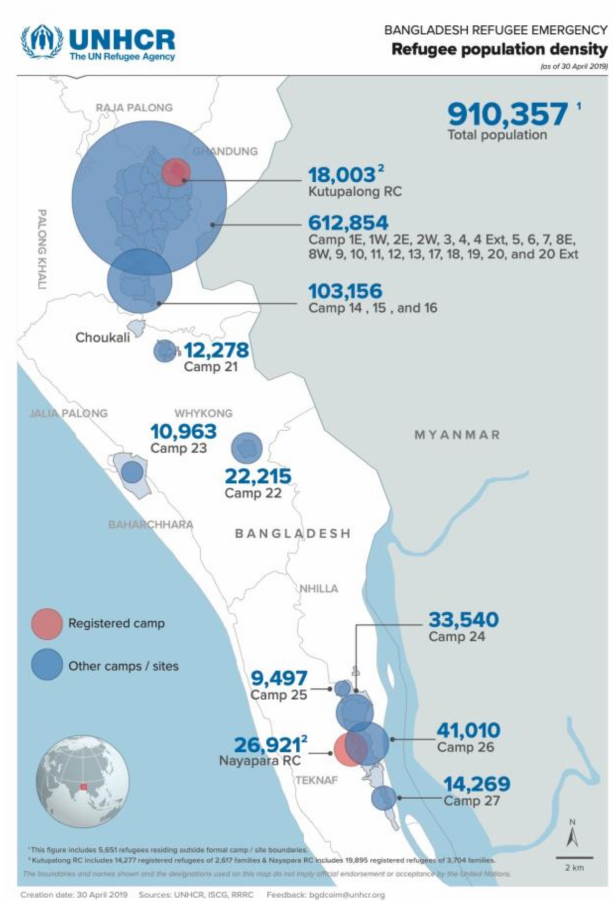
Figure 1. Rohingya camps in Cox’s Bazar (Source: UNHCR); study sites camps 4, 18, 22,